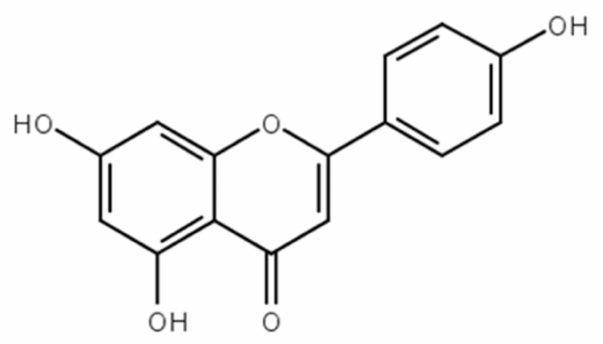
Figure 1. Chemical structure of apigenin (molecular weight: 270.24).